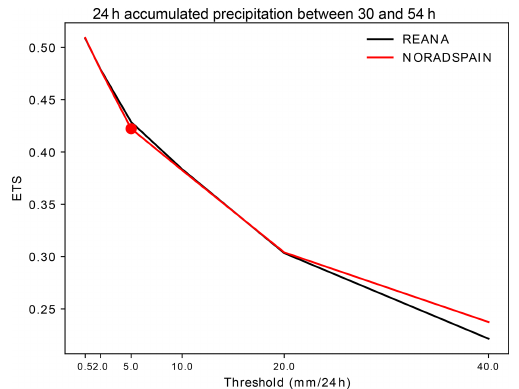
Figure 13. Equitable threat score (ETS) for the 24h accumulated precipitation obtained from the sum of eight 3h forecasts used as a background of the data assimilation cycle each day of the pe- riod from 5 September to 5 November 2012 computed over the AROME-WMED domain with rain gauges of the HyMeX database (version 4). Results for REANA are displayed in black, and those for NORADSPAIN are in red. Dots indicate that the difference be- tween the curves is statistically significant.